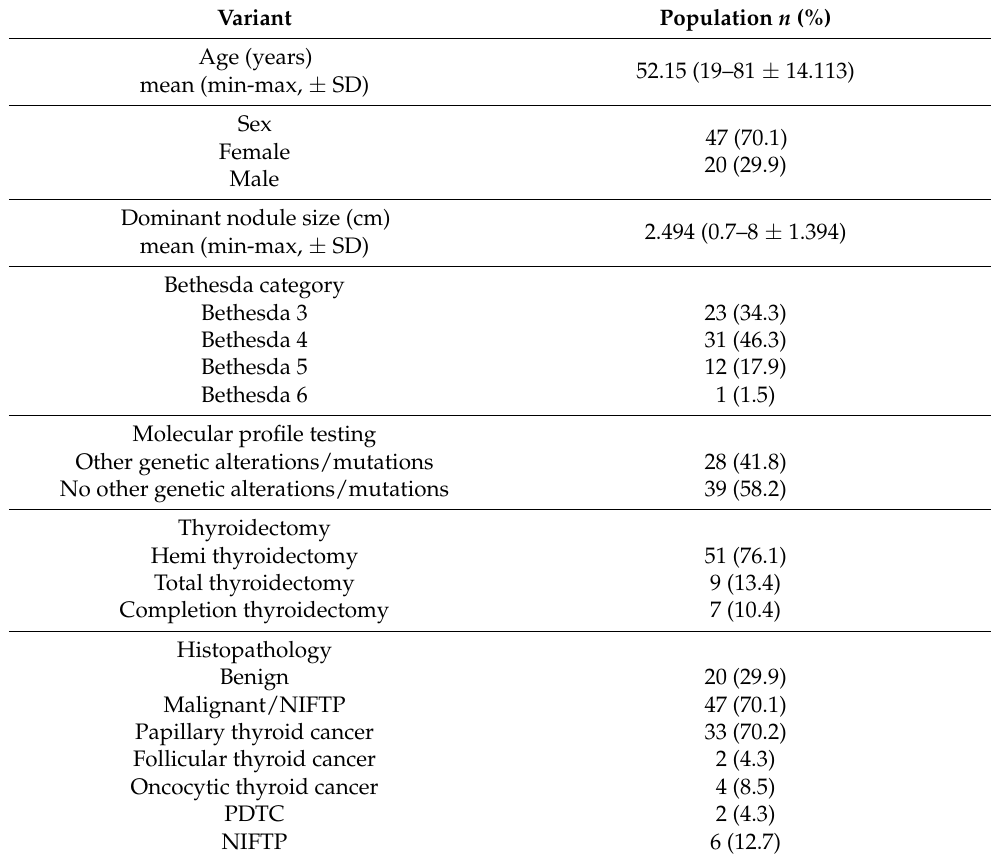
Table 1. Clinical and pathological characteristics of the 67 patients with thyroid cancer included in this